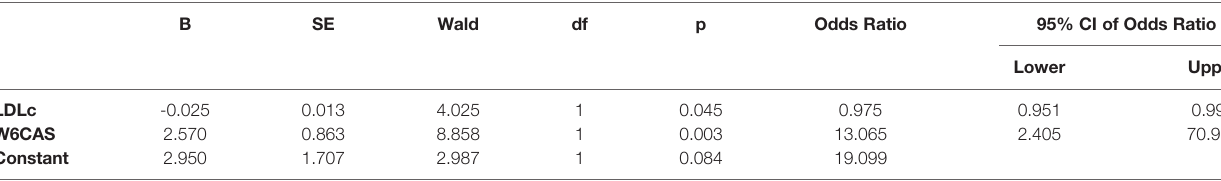
Final model built with covariates LDLc and